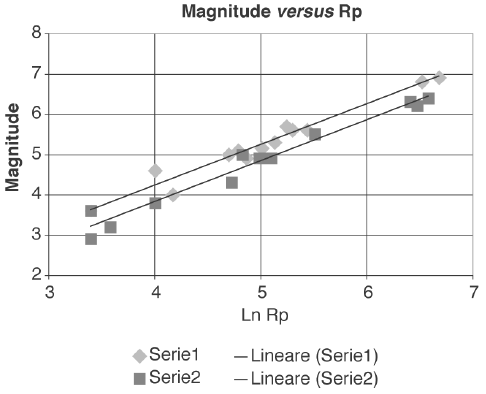
Fig. 3. Plot of magnitude versus Radius of Percep- tibility Rp for pre 1977 (diamond) and post 1977 (squares)